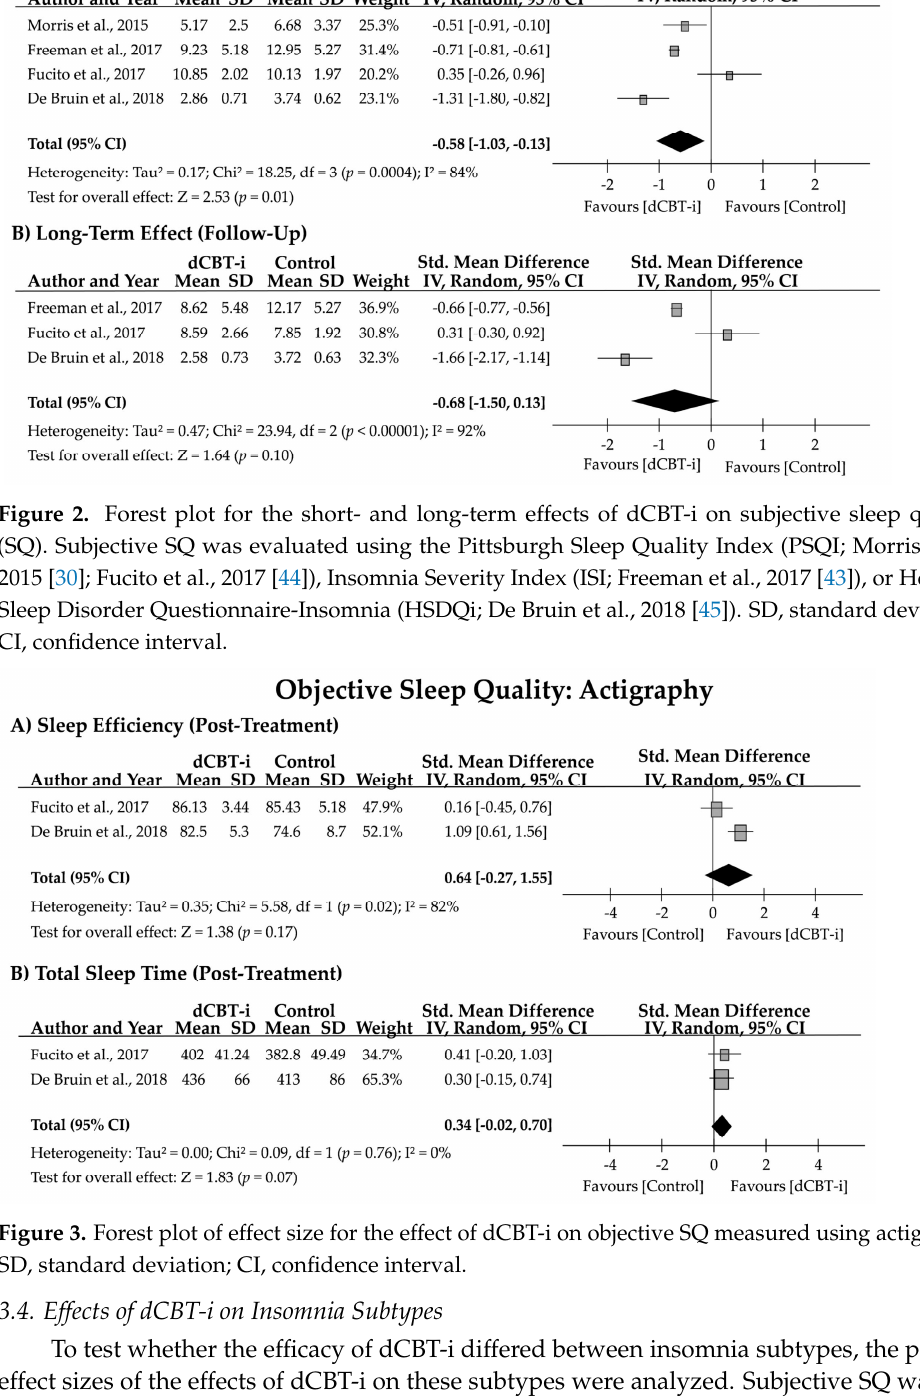
Figure 2. Forest plot for the short- and long-term effects of dCBT-i on subjective sleep quality (SQ). Subjective SQ was evaluated using the Pittsburgh Sleep Quality Index (PSQI; Morris et al., 2015 [30]; Fucito et al., 2017 [44]), Insomnia Severity Index (ISI; Freeman et al., 2017 [43]), or Holland Sleep Disorder Questionnaire-Insomnia (HSDQi; De Bruin et al., 2018 [45]). SD, standard devia- tion; CI, confidence interval.